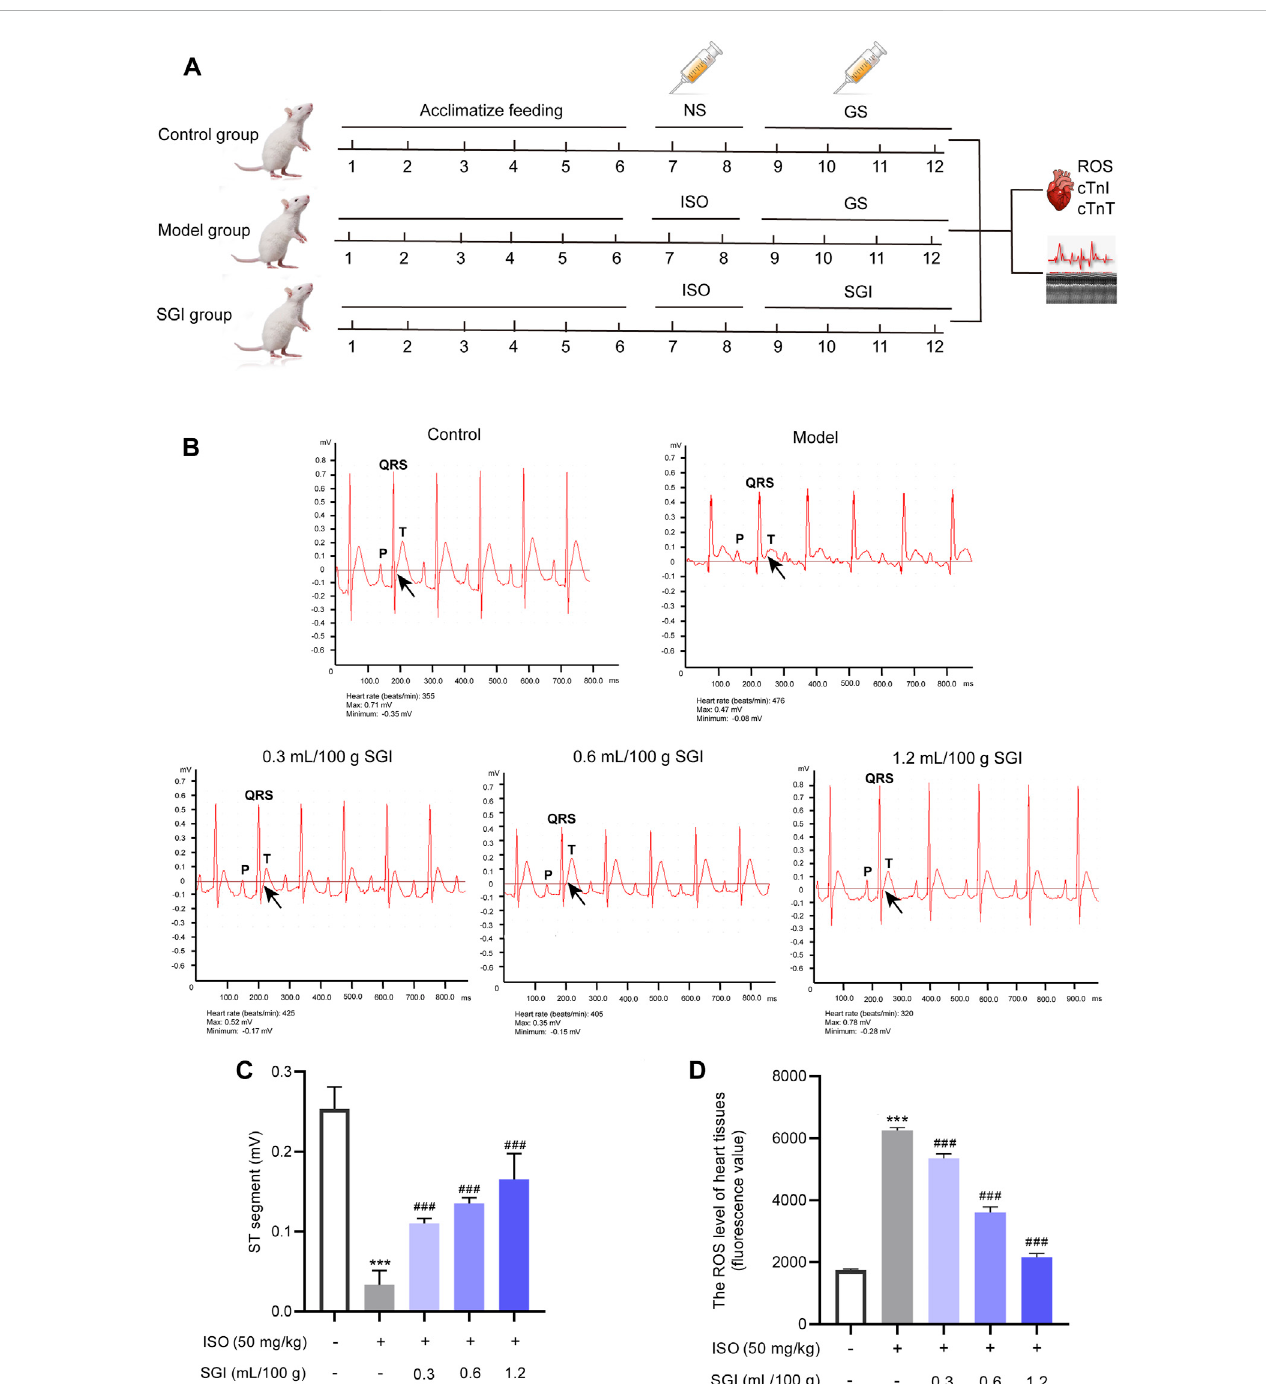
FIGURE 2 SGI improves ST-segment elevation and decreases ROS. (A) Study design of the current study. Detection of the ECG (B) , ST-segment values (C) , and the ROS level in the heart tissues ( fl uorescence value) (D) of MI rats by using a BL-420 biological function experiment system and DCFH-DA probe, respectively. *** p < .001 vs. the control group; ### p < .001 vs. the model